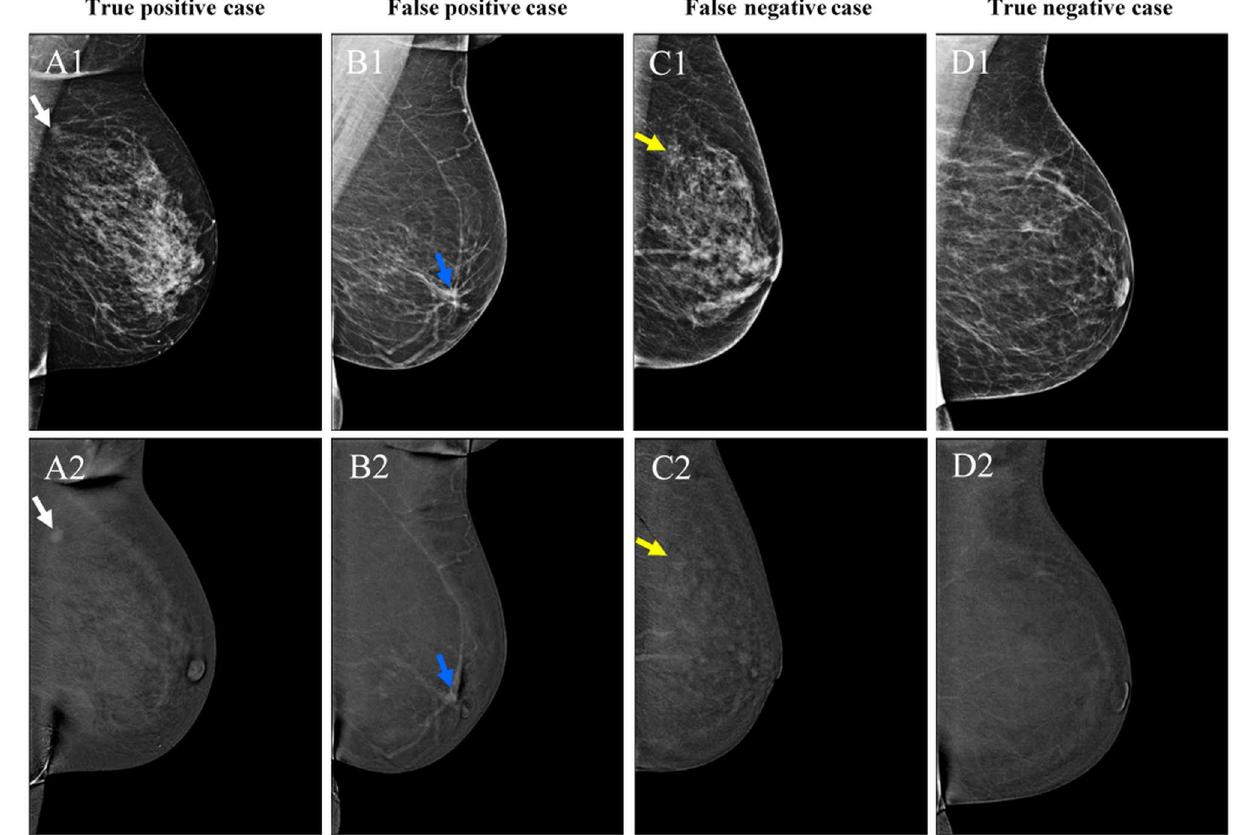
Figure 3. Examples of a true positive ( A ), false positive ( B ), false negative case ( C ), and true negative case ( D ). Top row represents the low-energy images, bottom row represents the recombined images. A1 shows an ill-defined, round mass anterior to the pectoral muscle (white arrow). The mass shows enhancement (A2). In B1, an ill-defined mass can be observed in the retro areolar zone with spiculated margins, also showing enhancement on the recombined images (B2, blue arrow). In C1 and C2, none of the radiologists classified this case as malignant, although a cancer was present as a subtle, ill-defined focal asymmetry at the site of the yellow arrow. The distortion did not show any enhancement. Finally, D1 and D2 show a negative case (no abnormalities or focal enhancement visible in the breast). However, this patient suffered from an axillary lymphoma and was therefore classified as ‘negative’, as no breast cancer was detected. Histopathological results from A , B and C were invasive carcinoma of no special type, fibroglandular tissue, and invasive lobular carcinoma,